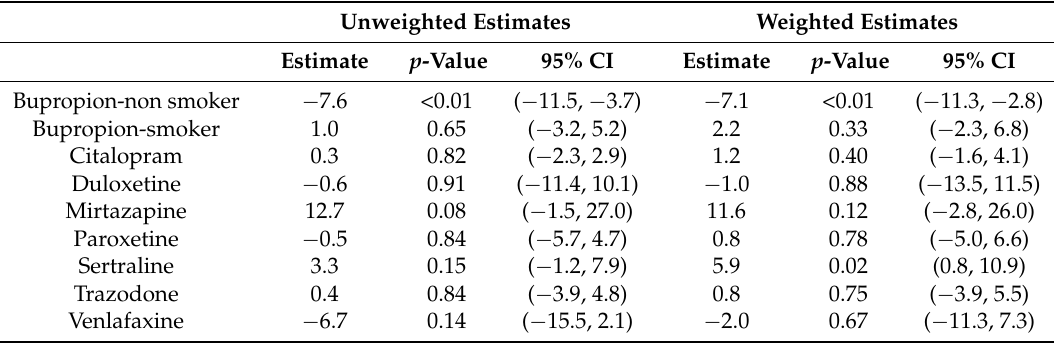
Table 2. Estimated 2-year weight change (lbs) for users of the various drug groups compared to fluoxetine users based on the intent-to-treat analysis *. Unweighted Estimates